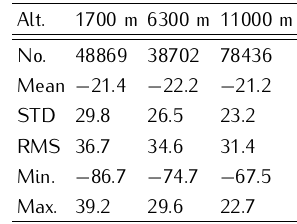
Table 1. Statisticsoftheairbornegravityanomaliesatthreealtitudes. Units in mGal.